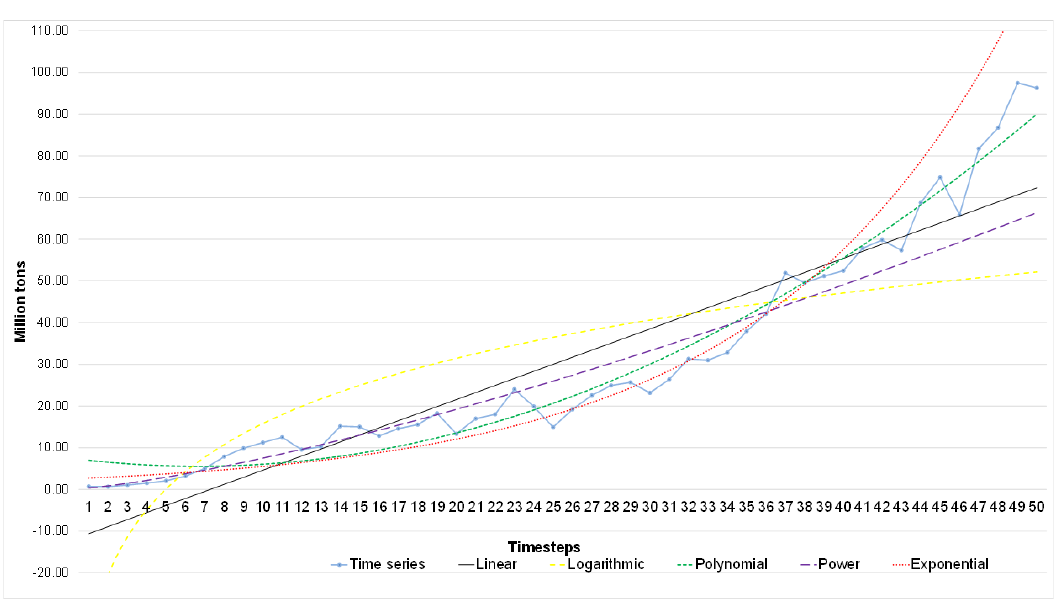
Figure 6. Original time series for